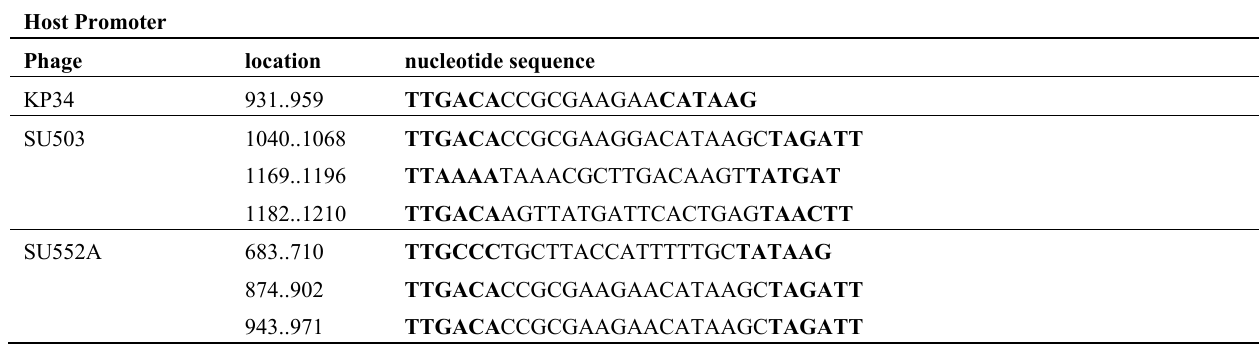
Table 3. Regulatory sequences of the phages in the suggested “Kp34likevirus” genus. Conserved motifs are presented in bold while underlined nucleotides depict